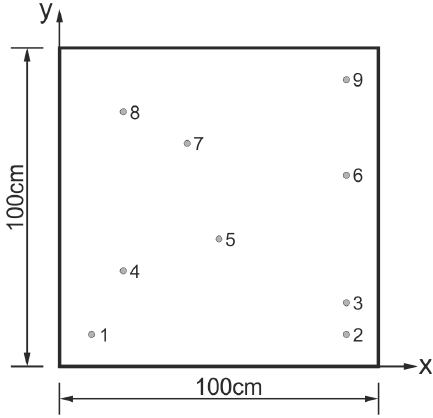
Figure 4. Geometry and arrangement of piezoelectric transducers on a square aluminum